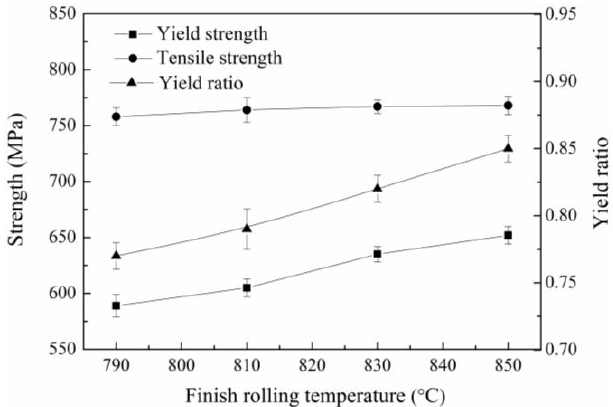
Figure 5 . Results of the tensile tests, as a function of the finish rolling temperature.